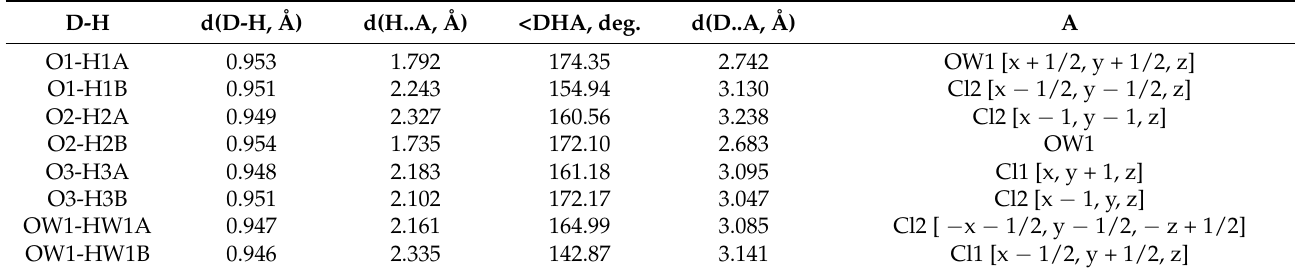
Table 2. Hydrogen bonds in the inorganic layers.